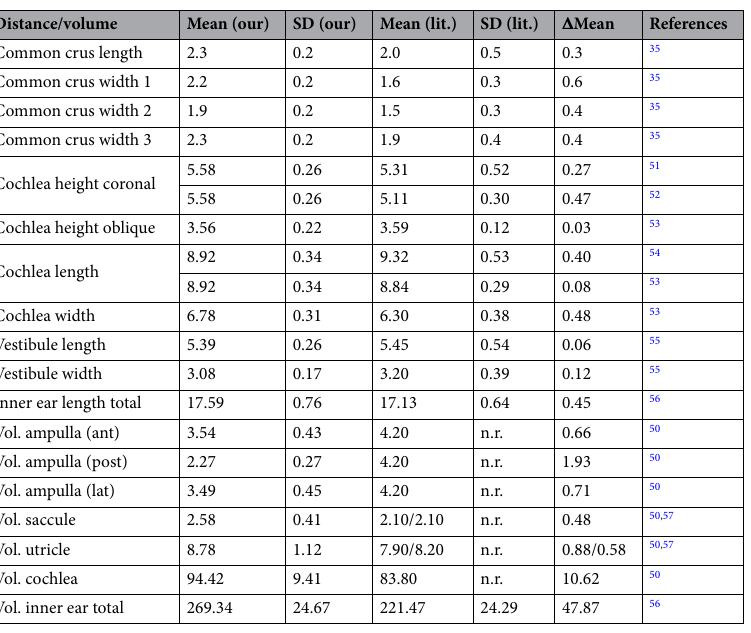
Table 4. Inner ear distances (in mm) and volumes (in mm 3 ) in IE-Map (“our”), compared to micro-CT based measurements in literature (“lit.”). (n.r. = not